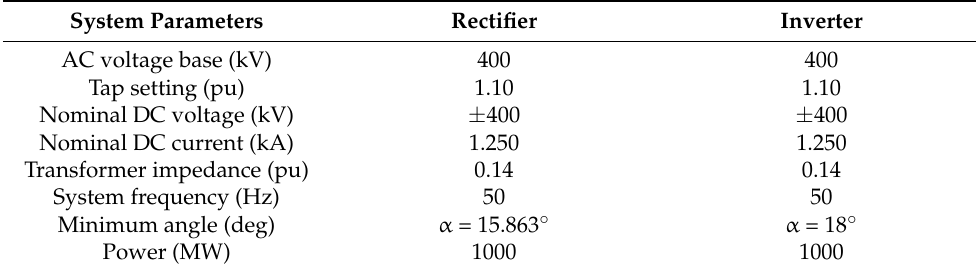
Table 6. Parameters of the HVDC system